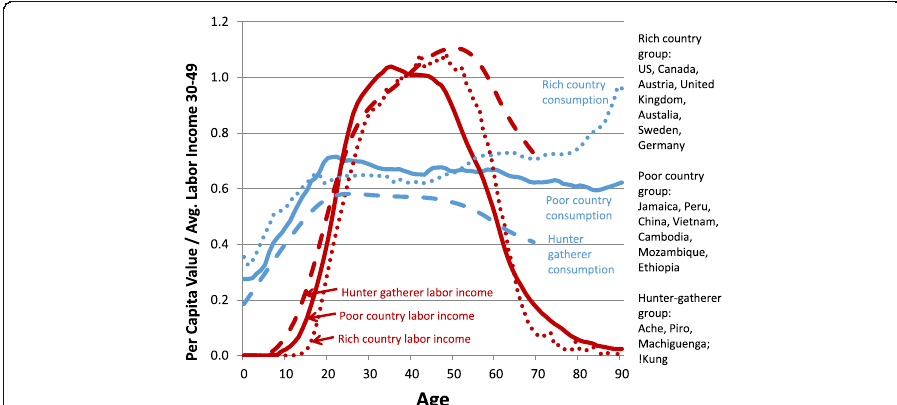
Fig. 1 Age profiles of HG, lower income, high income. Source: Calculated from National Transfer Accounts age profiles of consumption and labor income that are publicly available at the website ntaccounts.org. Lines are unweighted averages of data for the countries listed. Hunter-gatherer line is a weighted average of data from Kaplan (1994, all groups but !Kung) and Howell (2010, !Kung). !Kung is weighted one half, and each of the other three groups is weighted one sixth. See